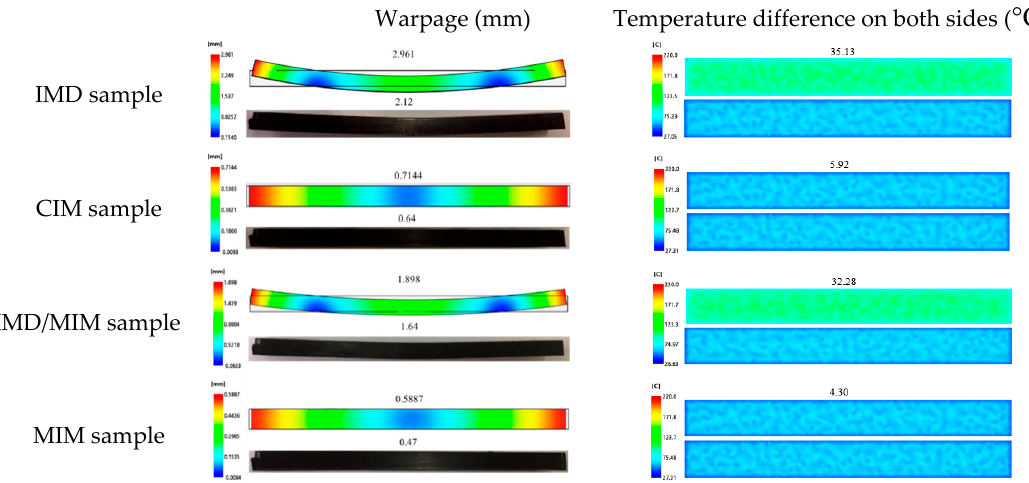
Figure 12. The comparison of the warpage and temperature difference on both sides among the IMD, CIM, IMD/MIM and MIM samples.